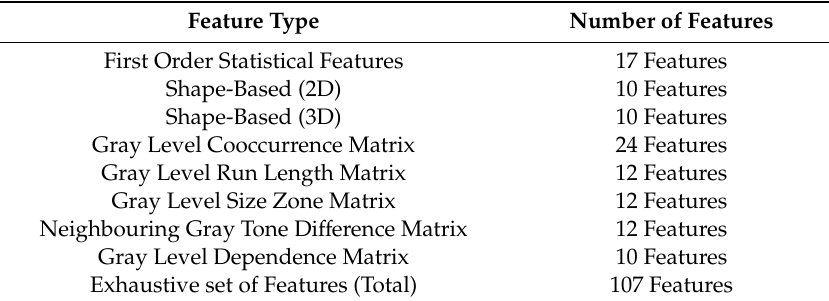
Table 6. Types of Features calculated from the segmented 3D Voxels of